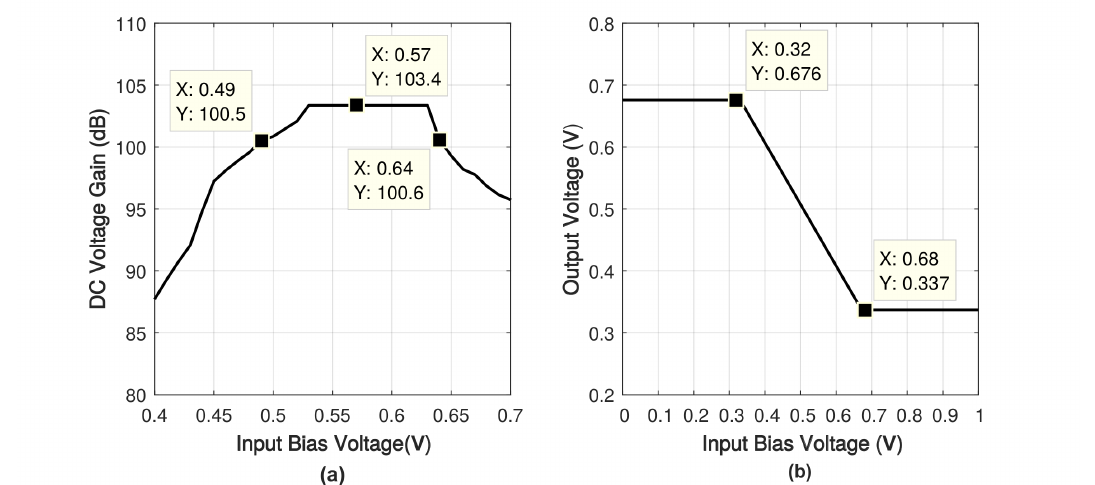
Figure 18. Simulated ( a ) input common-mode range ( b ) output swing of the proposed amplifier.